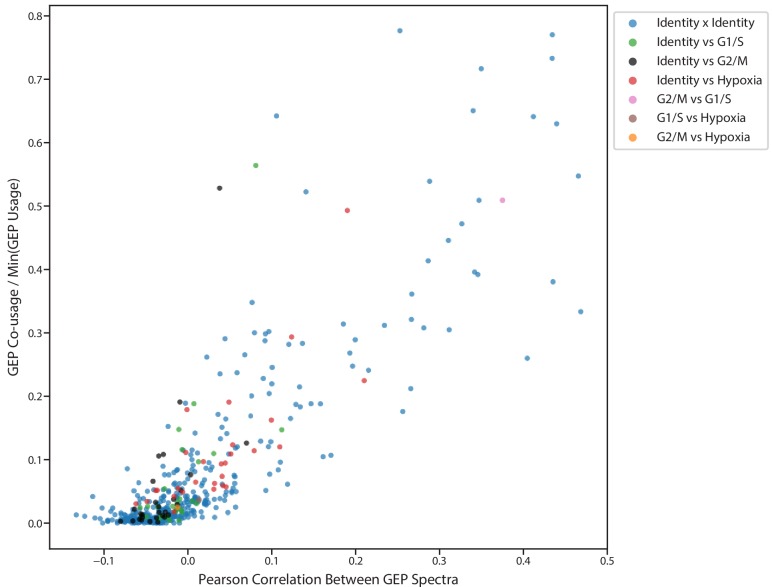
Correlation between GEP spectra pairs and fraction of cells that use both programs.Scatter plot of the pearson correlation between pairs of GEPs (X axis) and the fraction of cells that co-use the GEP pair (Y axis). Co-usage is defined as the number of cells with usage >0.1 for both programs divided by the number of cells that use the less common of the programs with usage >0.1. Dots are colored by whether or not the GEP pair is made up of identity or any of the three activity programs.